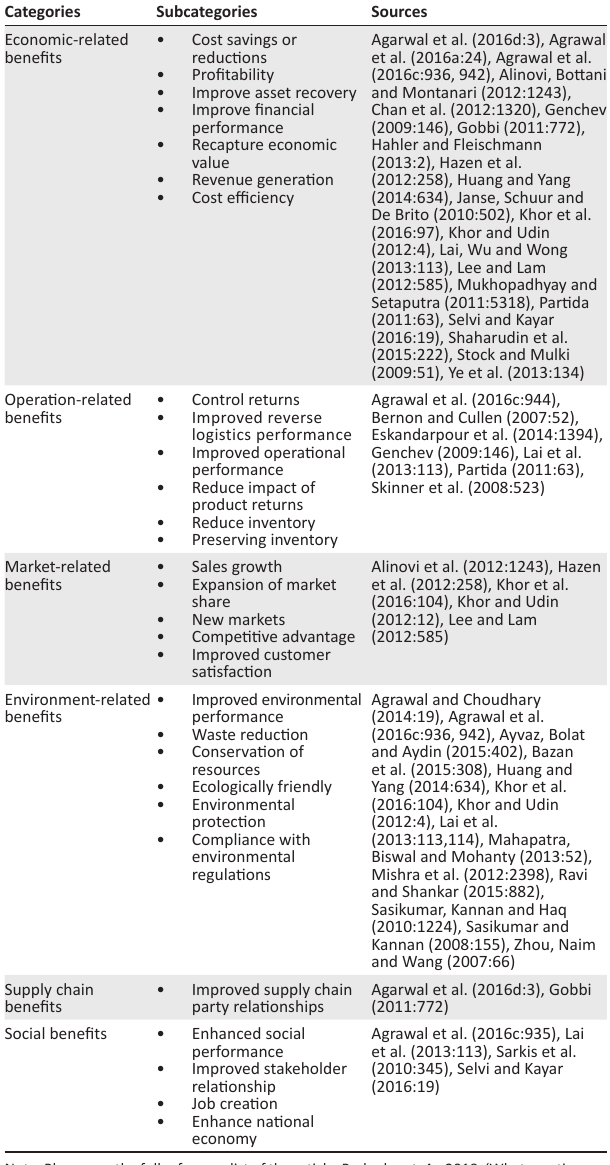
TABLE 3: Categories and subcategories of benefits associated of disposition